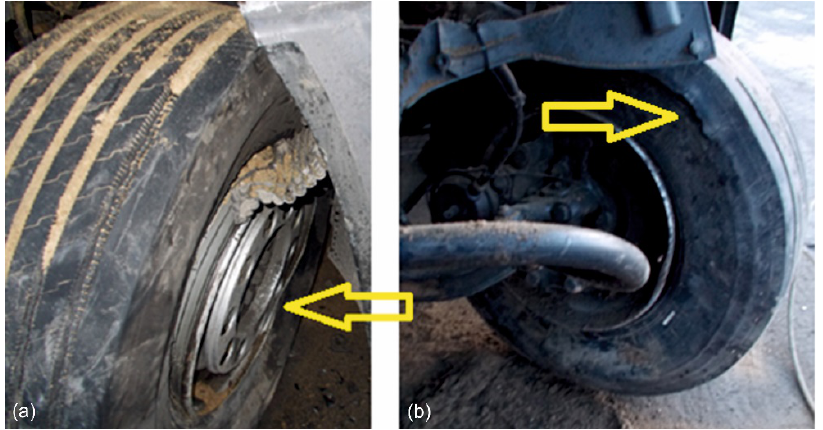
Figure 10. Relative position (indicated by the yellow arrow) of deformation: ( a ) of the outer edge of the rim of the left front wheel of the truck tractor; ( b ) the fracture of the tire sidewall on the inner